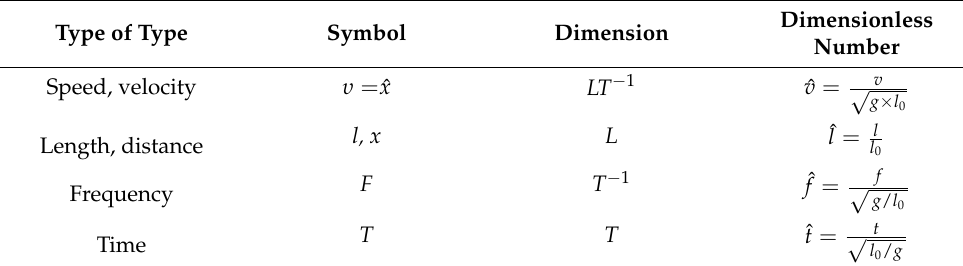
Figure 3. Gait factor. Table 4. Dimensionless Number Conversion Method. Table 4. Dimensionless Number Conversion